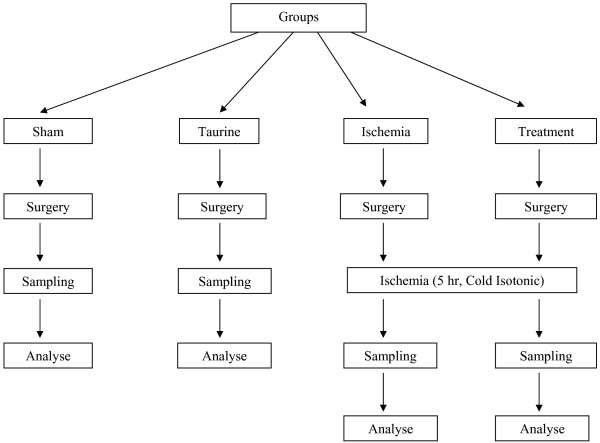
Consort diagram of the study.